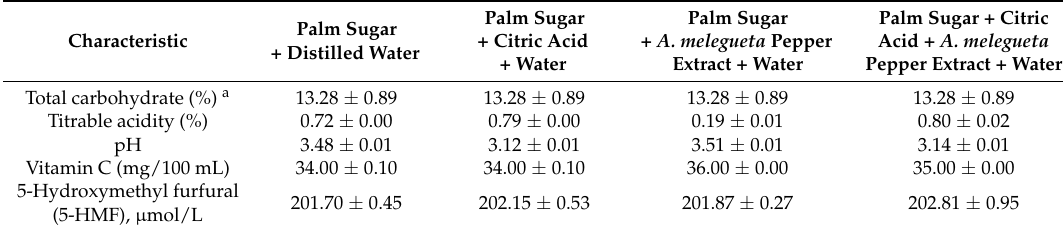
Table 6. Chemical characteristics of beverage formulations.